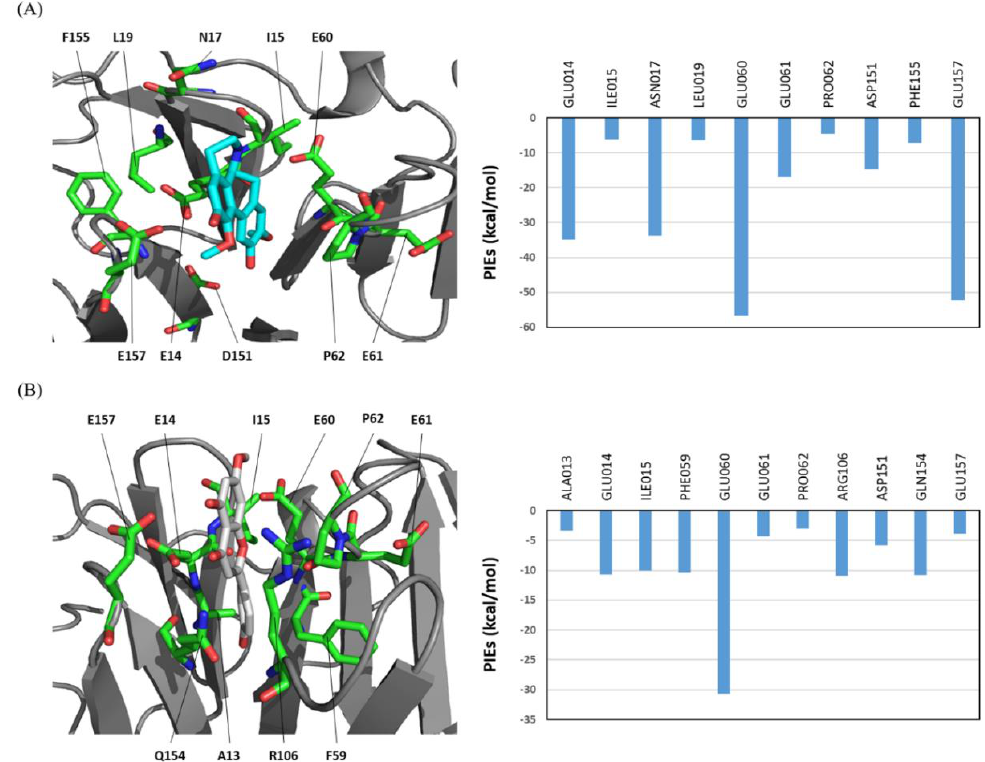
Figure 3. The FMO results for compounds 9 and 10 in complex with the hemopexin domain of MMP-9. ( A ) The structure of compound 9 binding to the hemopexin domain of MMP-9. The carbon atoms of 9 are shown in cyan. ( B ) The structure of compound 10 binding to the hemopexin domain of MMP-9. The carbon atoms of 10 are shown in white. The carbon atoms of the residues of MMP-9 are shown in green. The nitrogen and oxygen atoms are shown in blue and red, respectively. The right bar plot describes the PIEs of the significant residues in the hemopexin domain of MMP-9. All interactions shown here have attractive PIE values more stable than −3.0 kcal/mol. The PIE values are calculated at the FMO–RIMP2/PCM level.